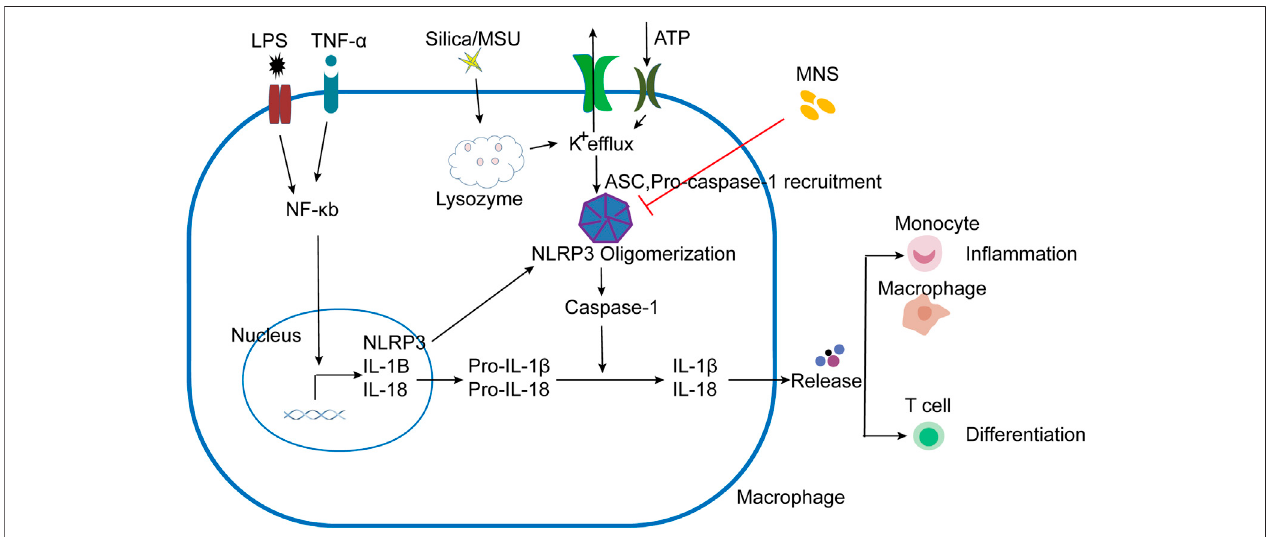
FIGURE 6 | Schematic presentation of MNS-alleviated in fl ammatory responses. LPS/TNF- α promoted the activation of the NF- κ B pathway, increased the transcriptionofNLRP3,Pro – IL-1 β ,andPro – IL-18.NLRP3respondedtostimuli(ATP,MSU,andsilica),inducedK+ef fl ux,andASCandpro – caspase-1wererecruitedto assemble and form NLRP3 oligomerization with the active caspase-1. Pro-IL-1 β and pro-IL-18 are cleaved into mature forms by caspase-1 following NLRP3 in fl ammasome activation. IL-1 β and other cytokines were released to induce the aggregation of mononuclear/macrophages and Th cell differentiation. When administered with MNS, NLRP3 in fl ammasome activation was prevented and cytokine maturation release was reduced, thereby alleviating the in fl ammatory response.